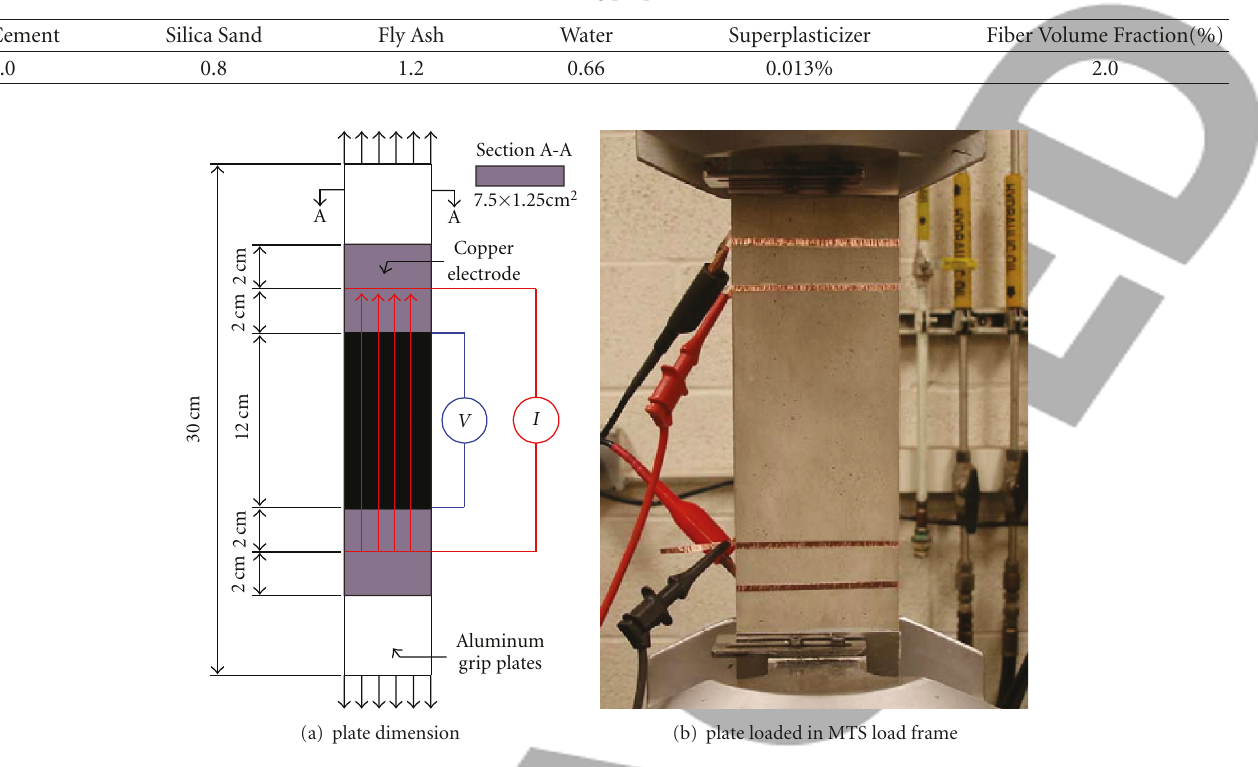
Table 1: Material Mixing proportion of PVA-ECC.